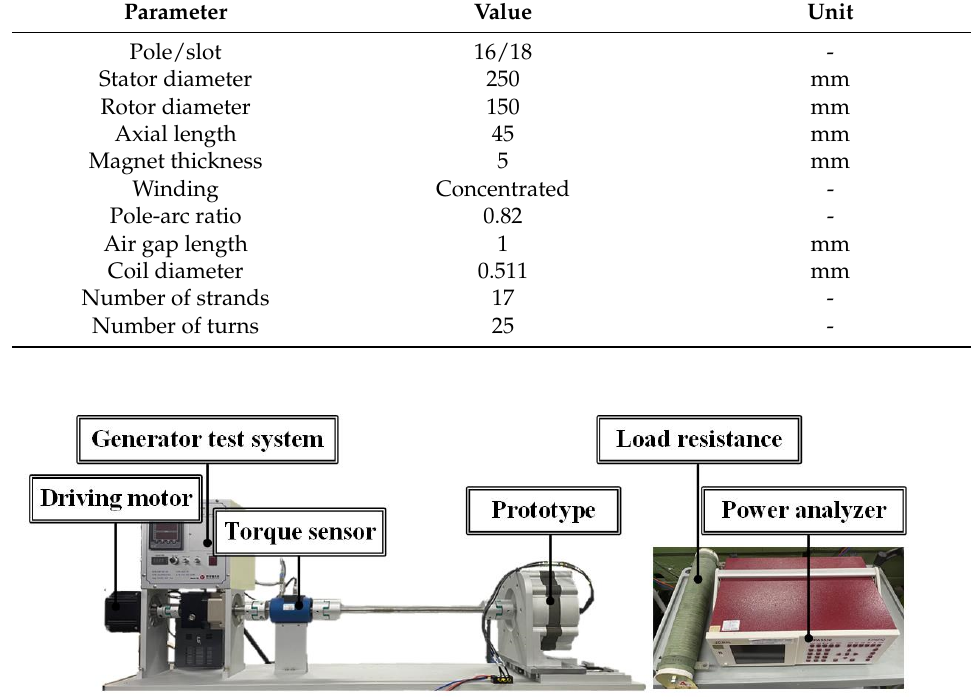
Figure 12. PMSG setup for experimental verification.